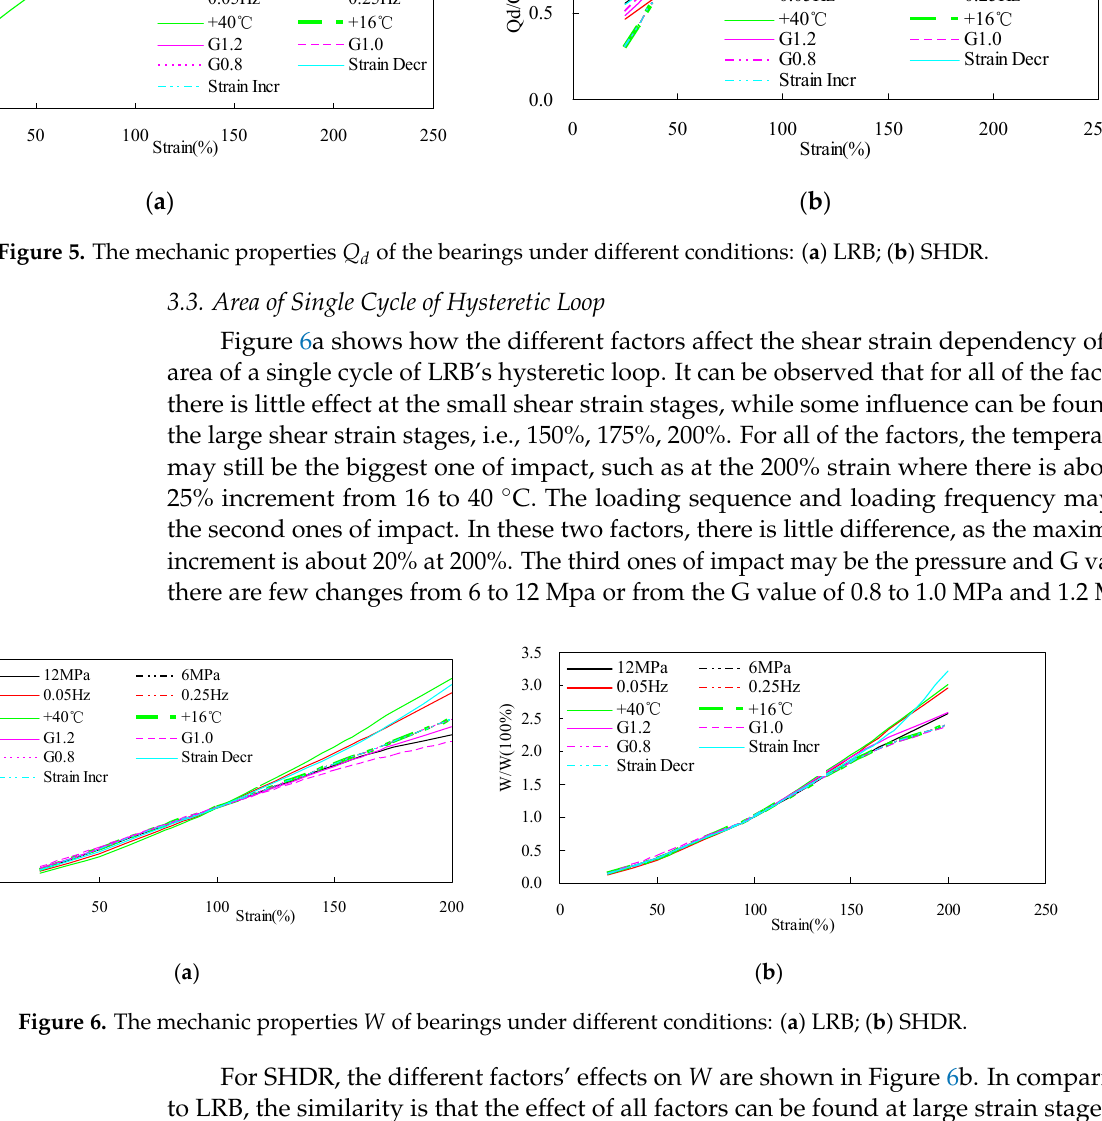
Figure 6. The mechanic properties W of bearings under different conditions: ( a ) LRB; ( b ) SHDR. For SHDR, the different factors’ effects on W are shown in Figure 6b. In comparison to LRB, the similarity is that the effect of all factors can be found at large strain stages; in terms of difference, the biggest factor of impact is not the temperature but the loading sequence. The second factor of impact is the temperature and the loading frequency, with the maximum change of about 25% at the 200% strain. The G value and pressure may be the third factors of impact; there is little difference for the two factors, with the maximum change being at 8% at the 200%